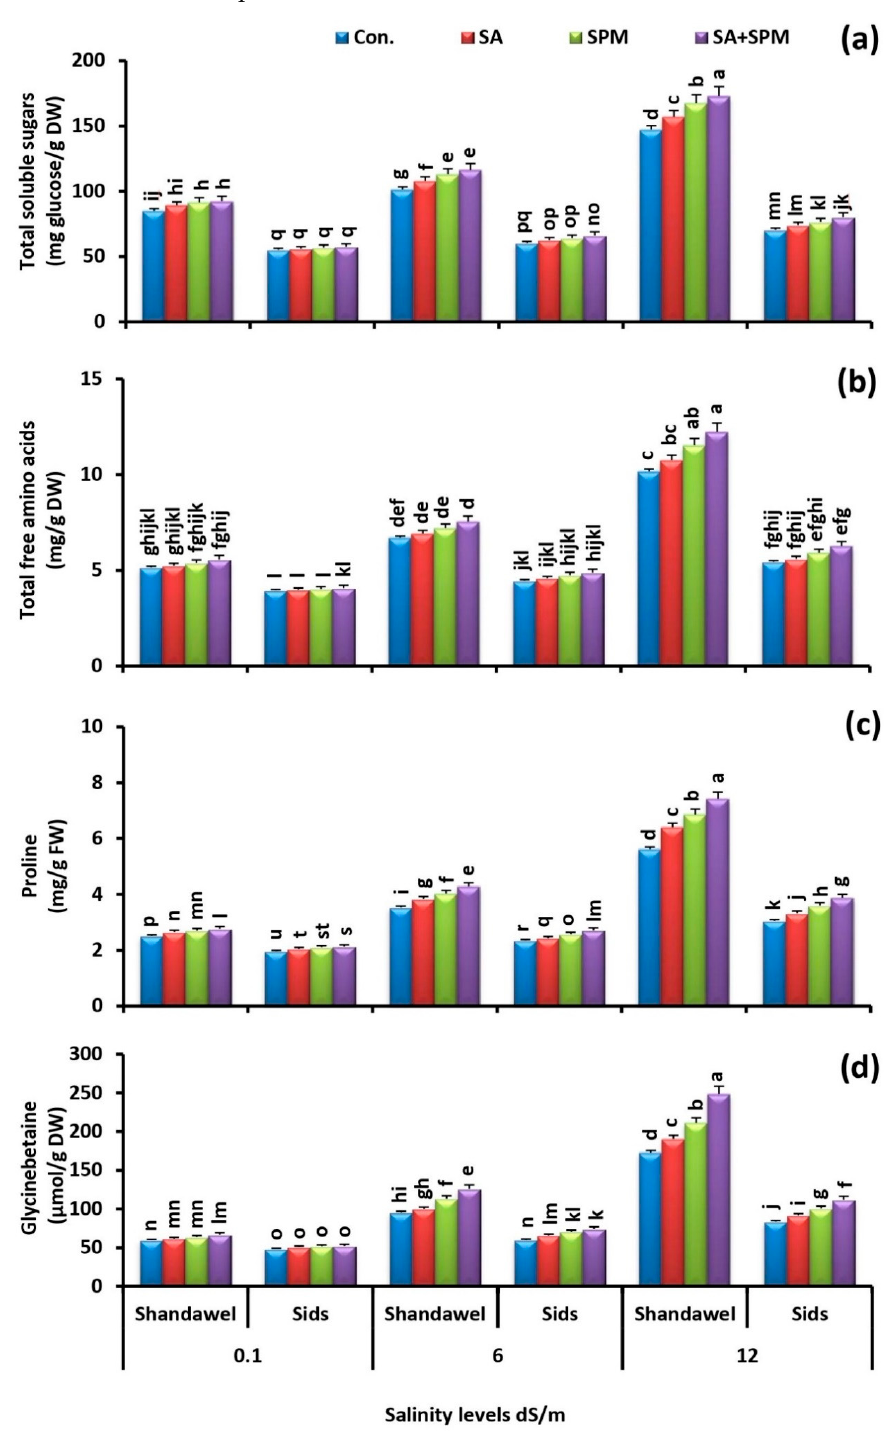
Figure 9. Influence of salicylic acid (SA; 100 mgL − 1 ) and/or spermine (SPM; 30 mgL − 1 ) on the concentration of ( a ) total soluble sugars, ( b ) total free amino acids, ( c ) proline, and ( d )